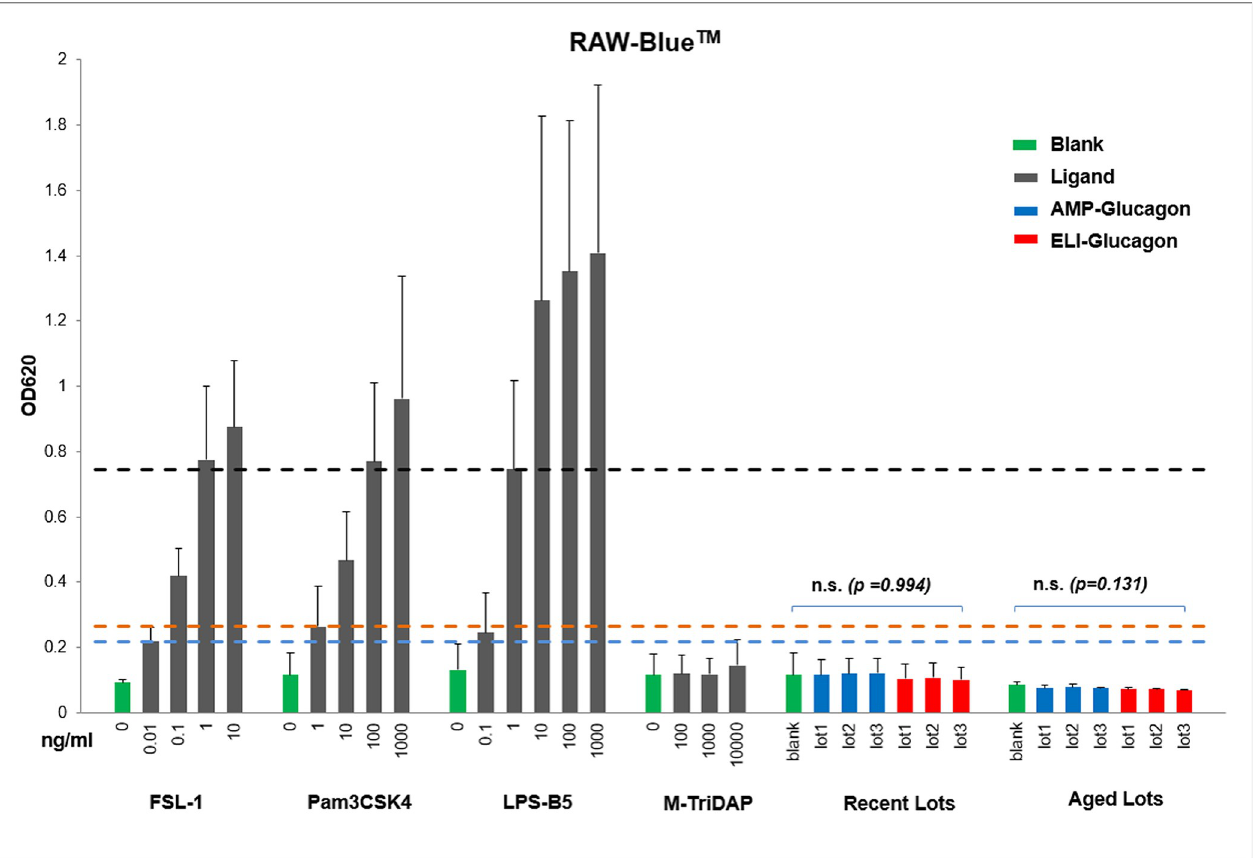
Fig 1. Comparison of innate immune response of AMP-Glucagon and ELI-Glucagon in RAW-Blue ™ cells. 2.5 x 10 4 RAW-Blue ™ cells were cultured for 24 hours with increasing concentration of ligands, and three lots of recent and aged AMP-glucagon and ELI-glucagon products. Transcription Factor NF- κ B activation was measured from the supernatant using QUANTI-Blue TM method. Each bar represents mean ± stdev of 3–5 repeats. “n.s.” means not significant by one-way ANOVA test. Dash lines represent the LLOD of the ligands.